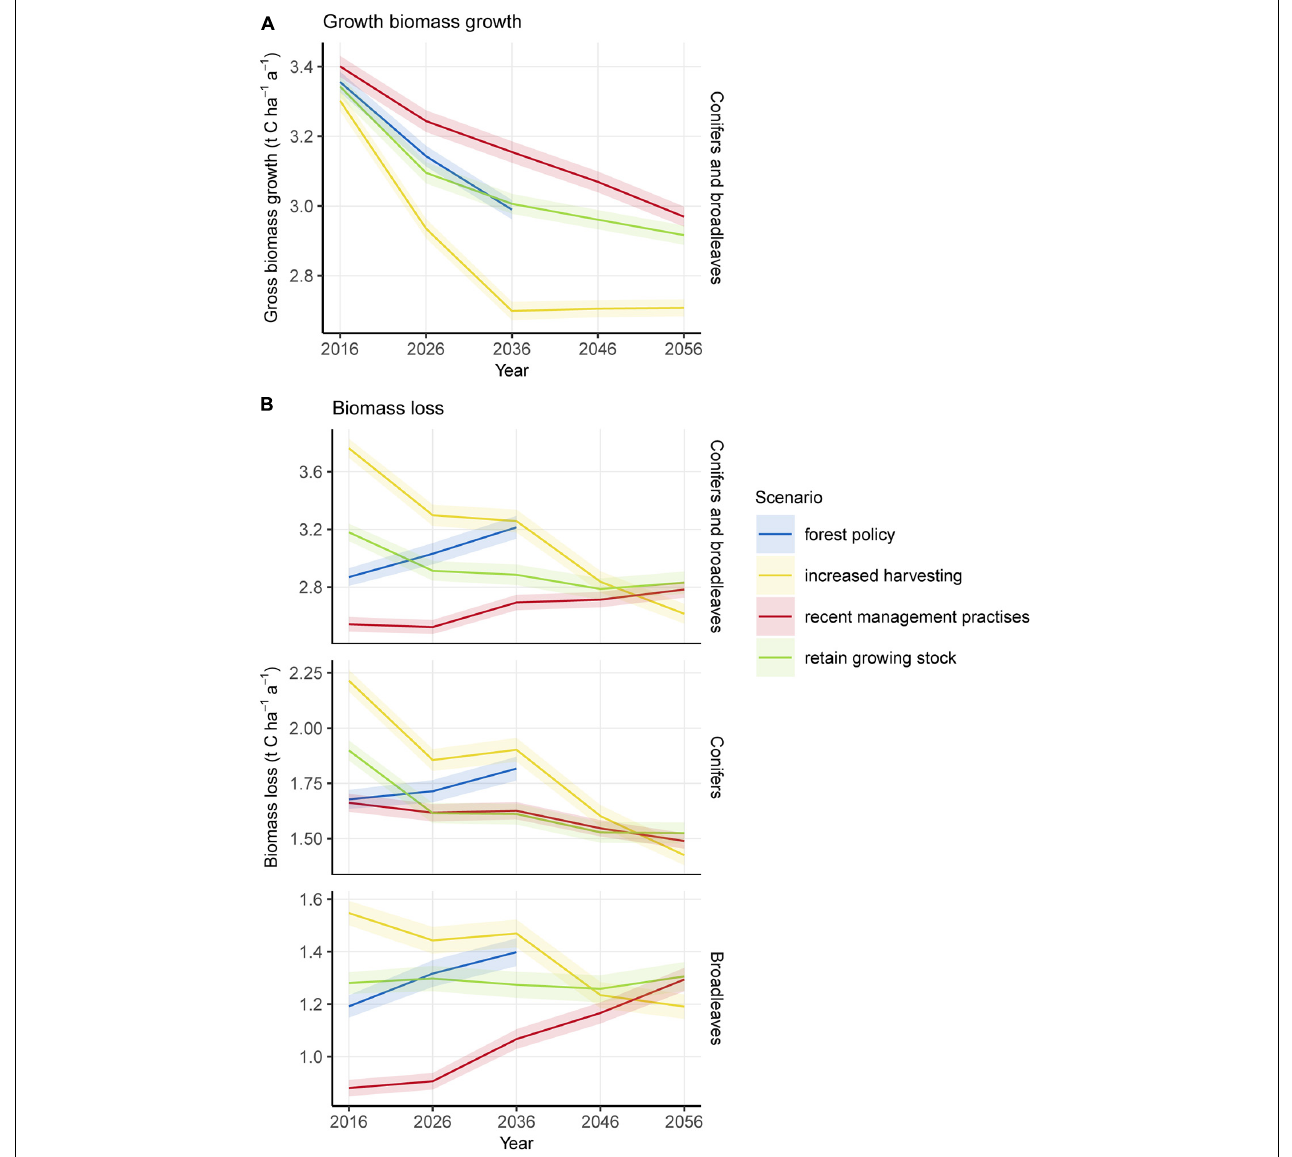
FIGURE 4 | (A) Gross biomass growth including ingrowth (above and below ground). (B) Losses (harvesting and mortality) in biomass for conifers and broadleaves. More details are presented in Supplementary Figures 2 , 3 . Simulations results include mean (thick line) and Standard Error of 30 replicates (shaded). The lines between each end of a time-step (e.g., between 2026 and 2036) are linearly